Question: What style of plot is this figure drawn as?
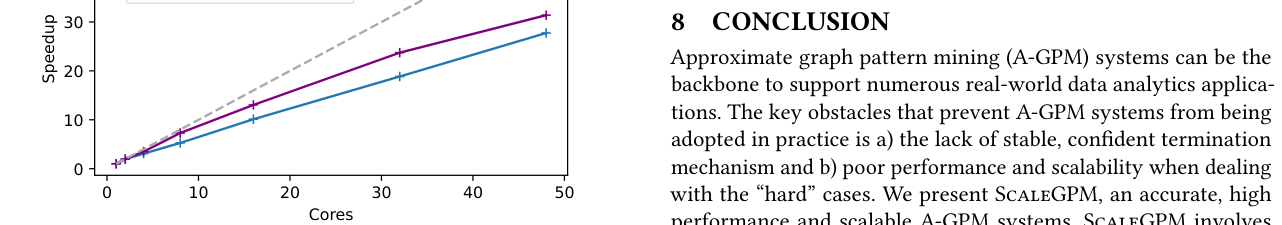
Answer: line